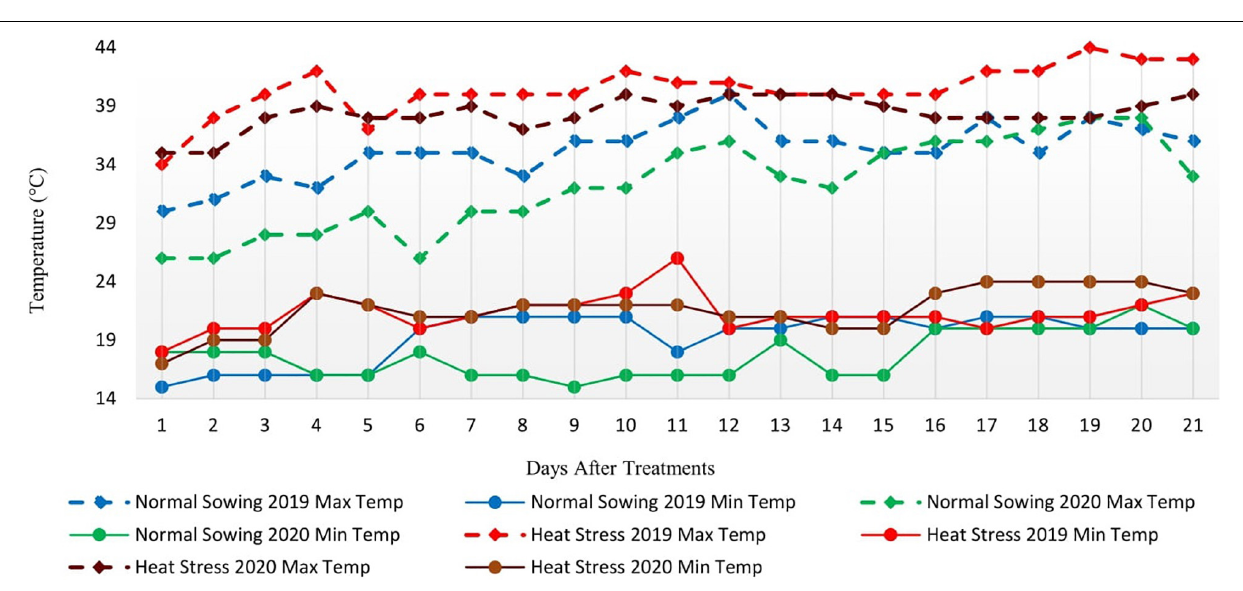
FIGURE 2 | Minimum and Maximum Temperature during Normal and heat stress Conditions (2019 and